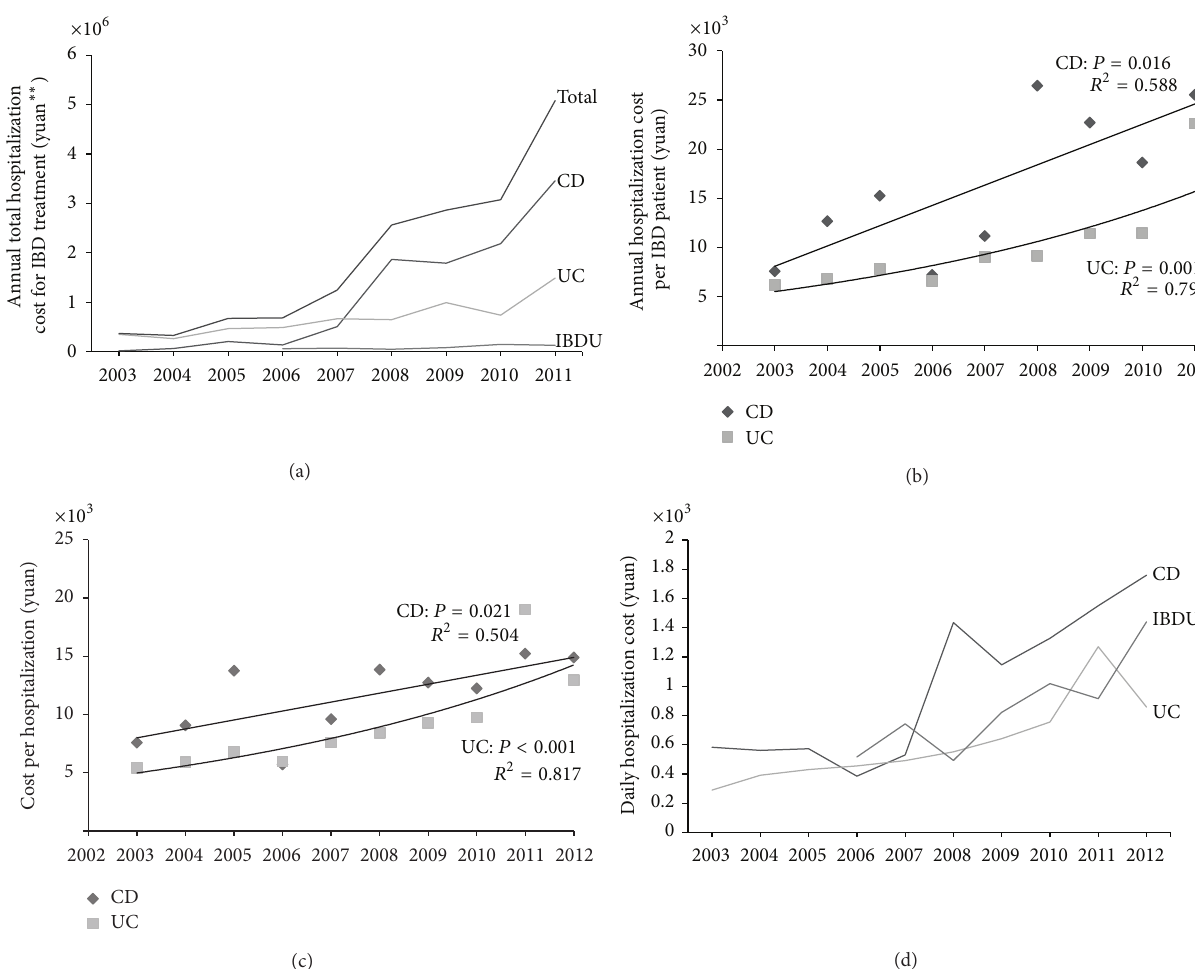
2002 2003 2004 2005 2006 2007 2008 2009 2010 2011 2012